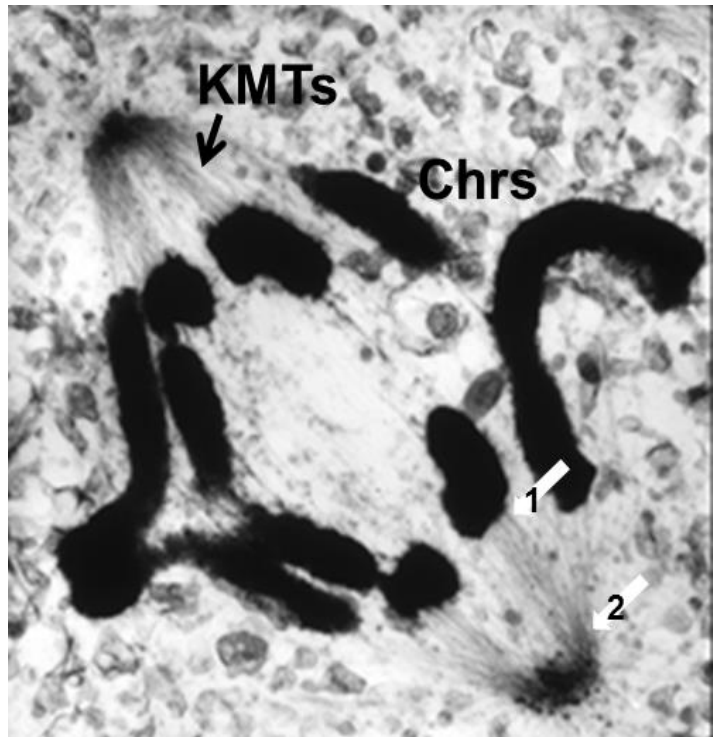
Figure 10. Thick section of a mammalian cell in anaphase, lysed before fixation to reduce the complexity of background staining. KMTs = kinetochore microtubules; Chrs = chromosomes. White arrows indicate sites of apparent attachment between MTs and a chromosome (1) and a pole (2). From McIntosh et al., 1975b [37]. By permission of the author.